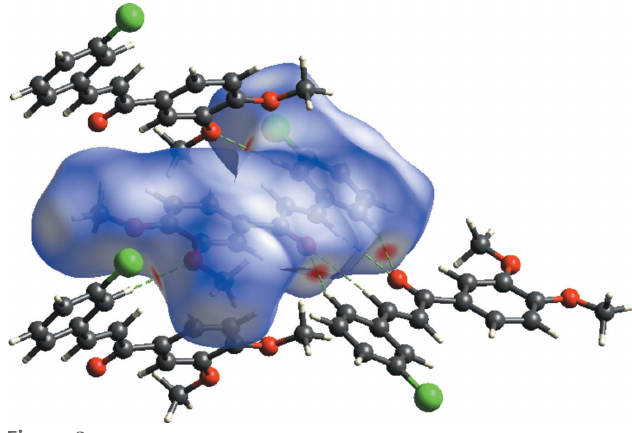
Figure 2 A view along the a axis of the crystal packing of the title compound. Intermolecular interactions are shown as dashed lines.